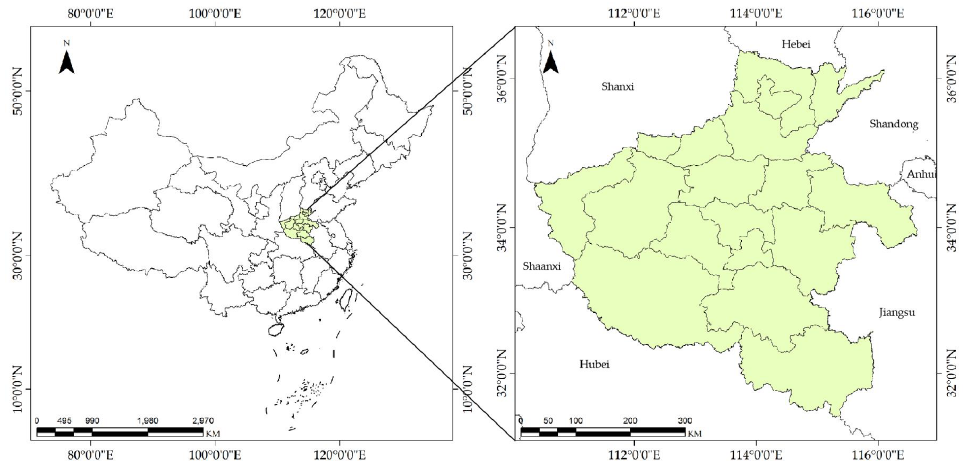
Figure 2. Spatial distribution map of the study area. The left figure shows the location of the study area in China, and the right figure shows the zoomed-in details of the study